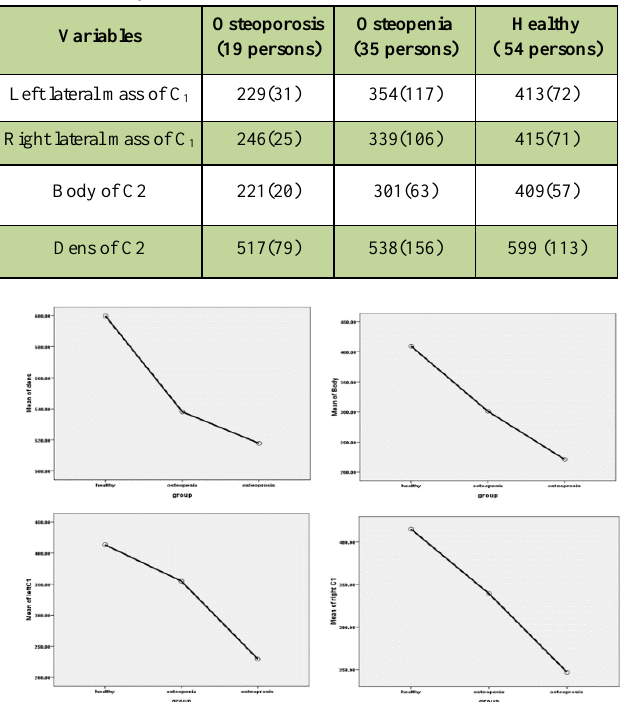
Table 4 provided the validity of RD values for predicting the risk